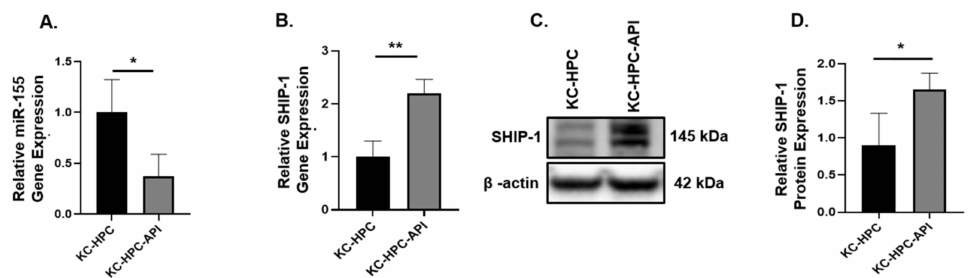
Figure 5. API treatment decreased miR-155 expression in KC-HPC mice, which correlated with an increase in SHIP-1 expression. Relative ( A ) miR-155 and ( B ) SHIP-1 gene expression in the tumors from KC-HPC and KC-HPC-API mice. ( C , D ) WB analysis and representative quantification of SHIP-1 protein from the tumors of KC-HPC and KC-HPC-API mice. Data are presented as the mean ± S.D. of KC-HPC ( n = 3–4), KC-HPC-API ( n = 3–4). * p < 0.05; ** p < 0.01 (by two-tailed t